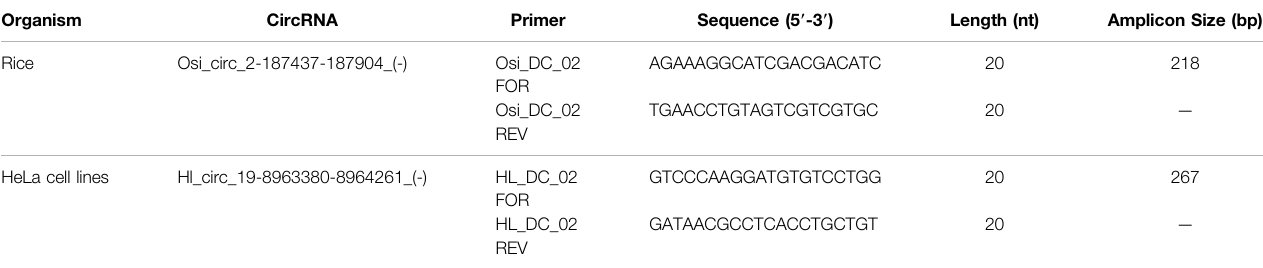
TABLE 1 | Table showing the list of divergent primers used in the